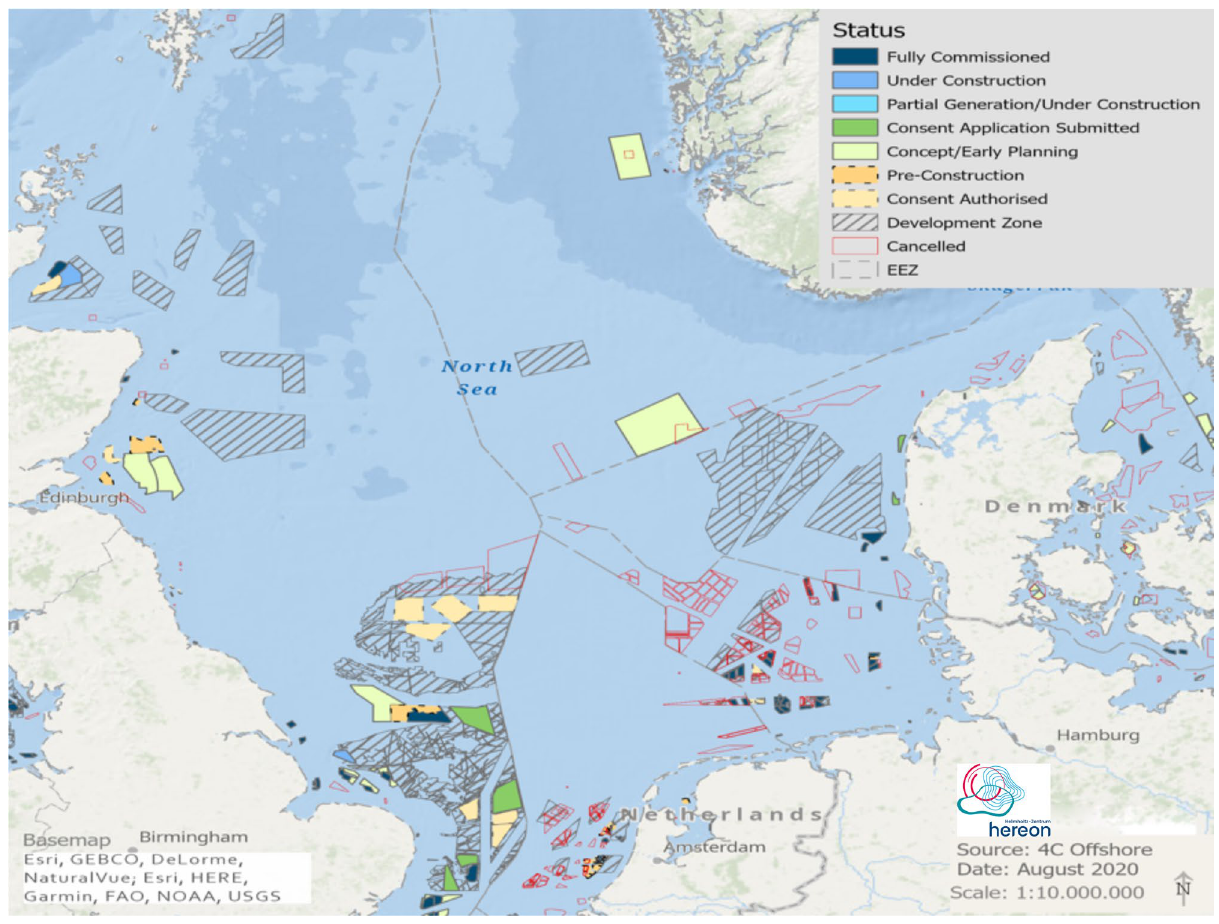
Figure 1. Distribution of OWFs in the North Sea (4c Offshore. https:// www. 4coff shore. com/ windf arms/, 2019). Colors indicate the planning status of the OWFs by 2019. This map was created by Ulrike Kleeberg with ArcGIS Pro 10.7 (ESRI Inc. ArcGIS Pro 10.7,